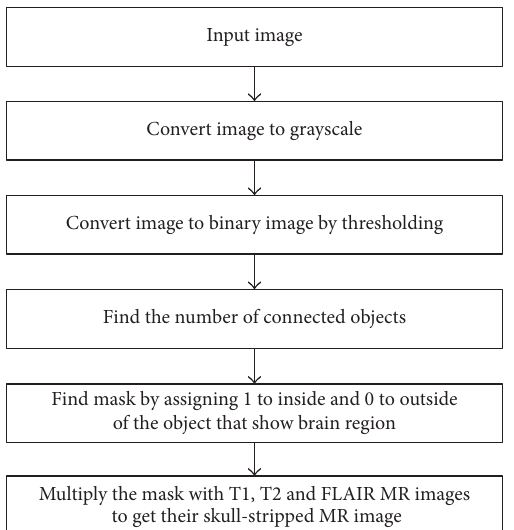
Figure 2: Steps used in the skull stripping